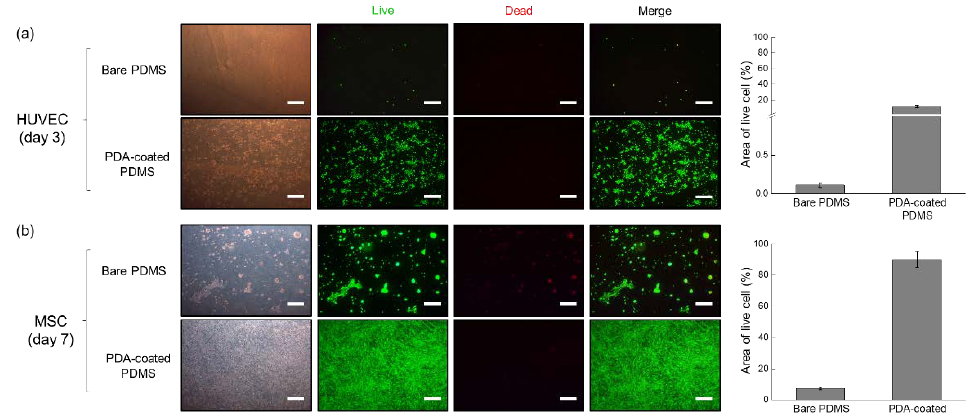
Figure 5. Results of the live/dead cell assays performed on HUVECs and MSCs cultured on bare and PDA-coated PDMS surfaces. The percentage of the area occupied by live cells was calculated using the ImageJ software. ( a ) HUVECs were cultured for 3 days and ( b ) MSCs were cultured for 7 days. Scale bar = 500 μm.